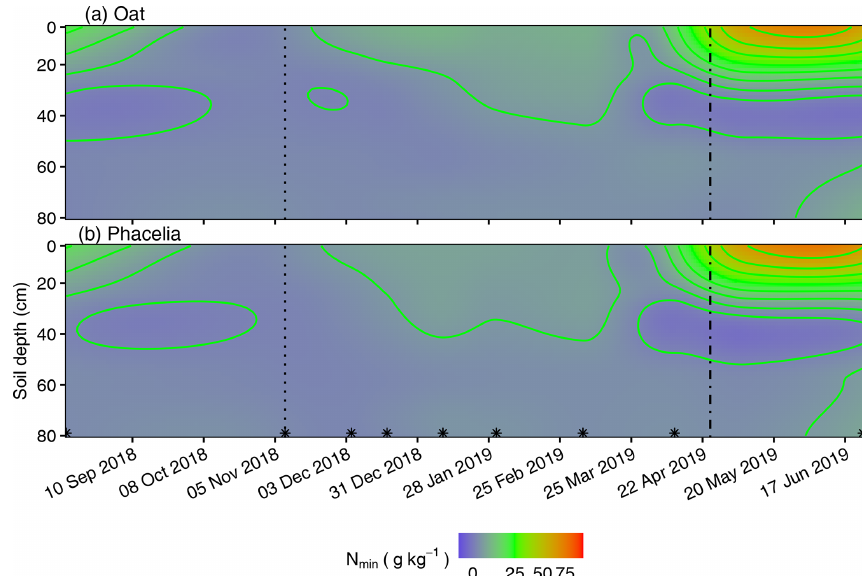
Figure 3. Spatiotemporal resolution of N min concentrations in soil spanning a 313d period under (a) oat and (b) phacelia. The dotted lines indicate CC termination, dashed lines mark the seeding of maize following CCs or fallow and asterisks indicate sampling dates.